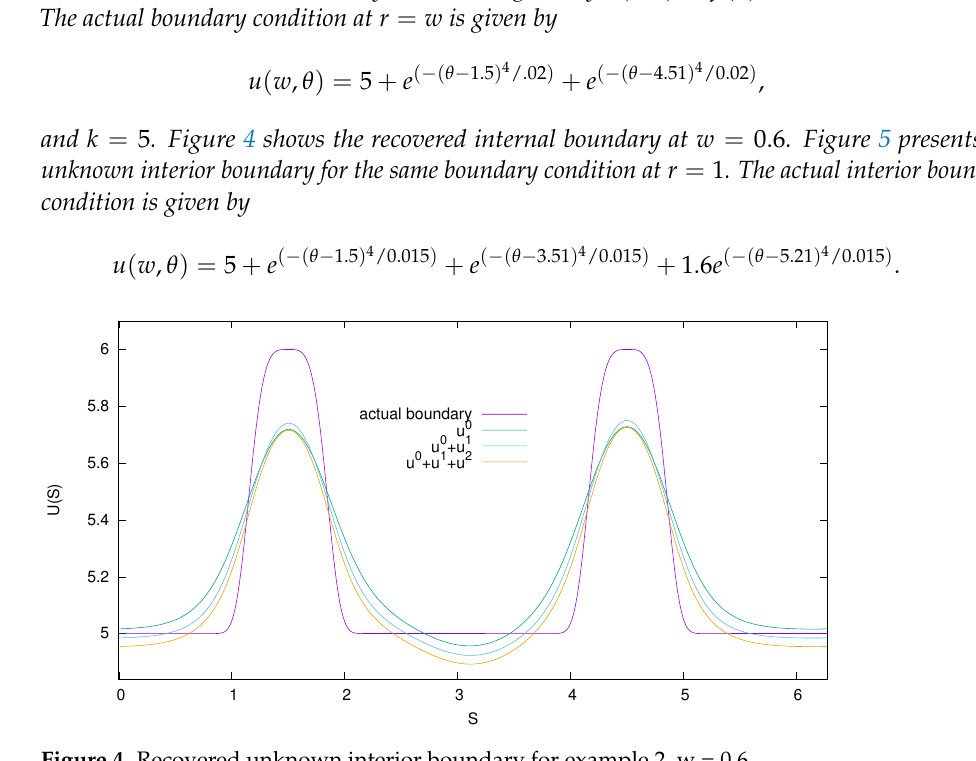
Figure 4. Recovered unknown interior boundary for example 2, w = 0.6.